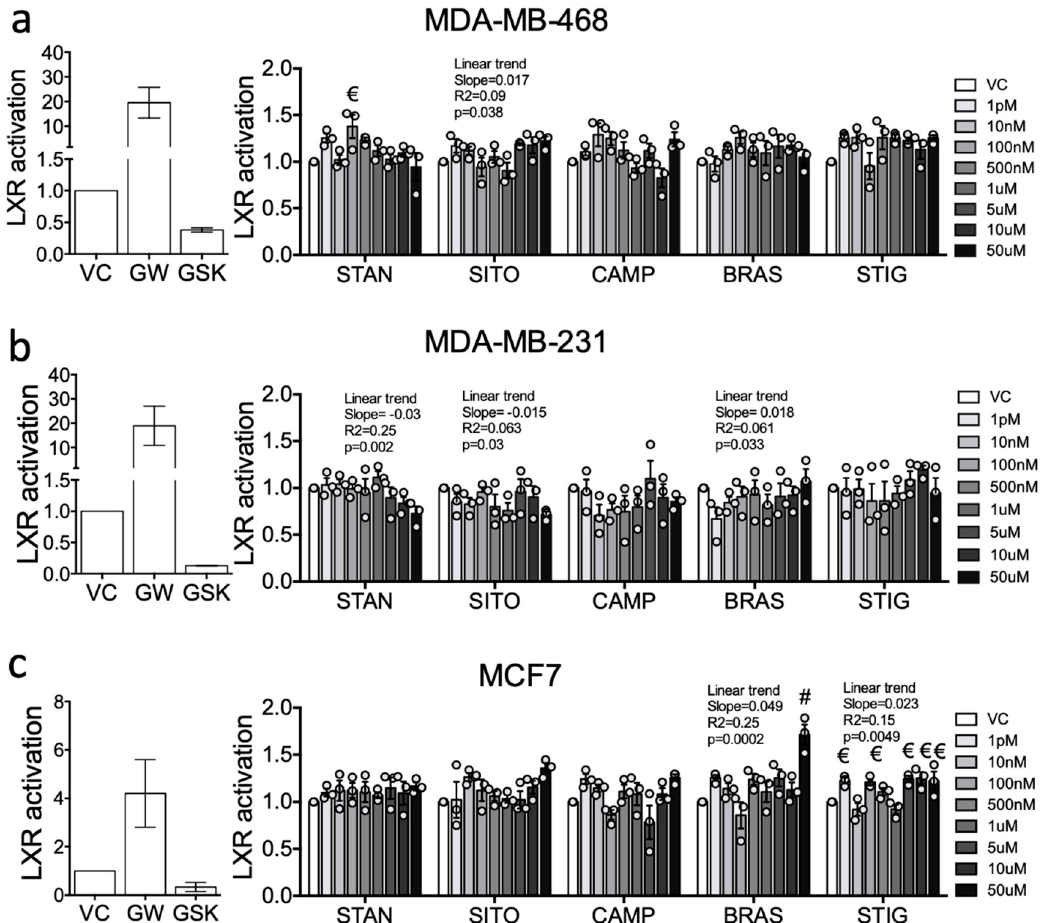
Figure 3. Liver X receptors (LXRs) is only weakly modulated by PSSs treatment in breast cancer cell lines. A luciferase reporter driven by an LXR alpha (LXRA) responsive promoter was stably transfected into ( a ) MDA-MB-468, ( b ) MDA-MB-231, and ( c ) MCF7. Relative luciferase activity